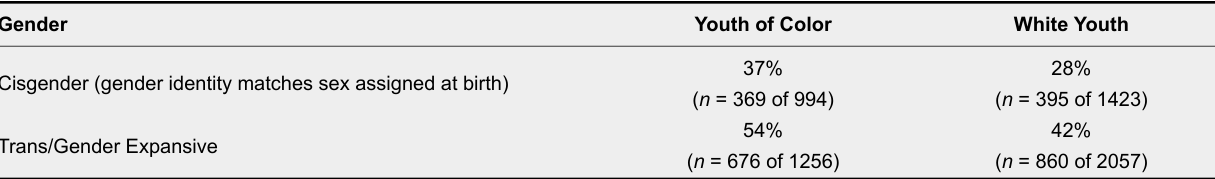
Percent of Youth Living With Housing Precarity: Race/Ethnicity and Gender